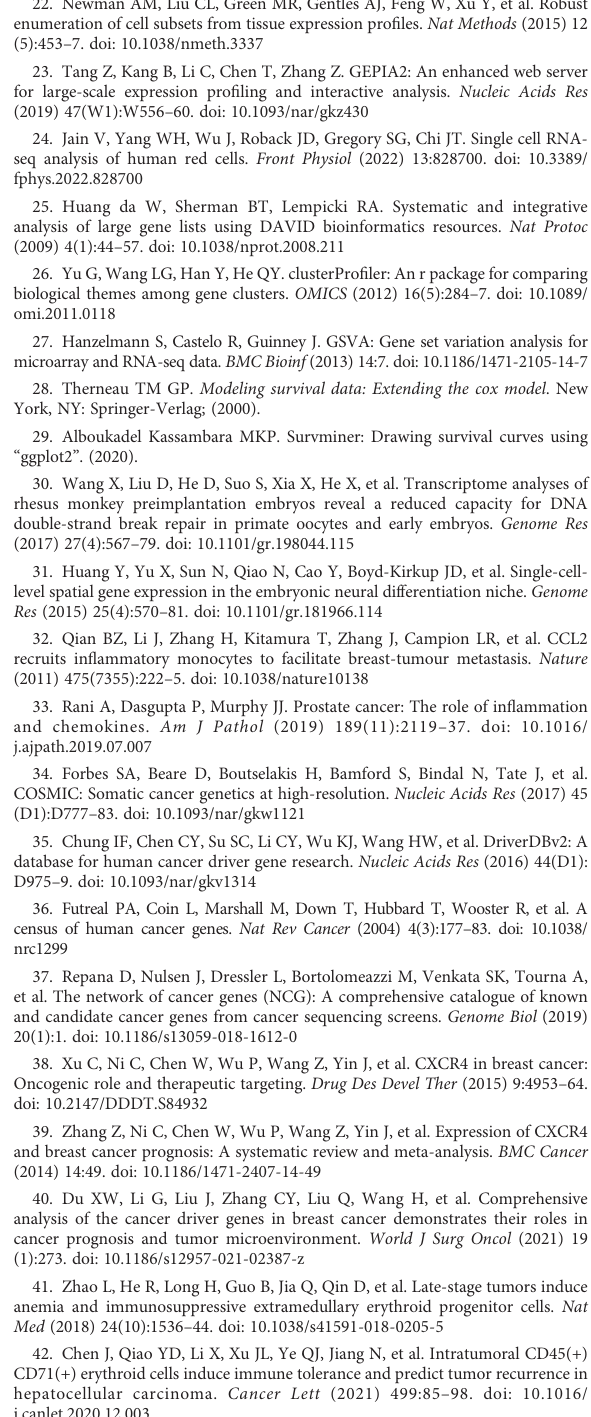
p-value > 0.05. Absolute score re fl ected the absolute proportion of blood cells in a mixture. (B) A heatmap showed the average content of different erythroid cells among normal, in fl ammation, and cancer